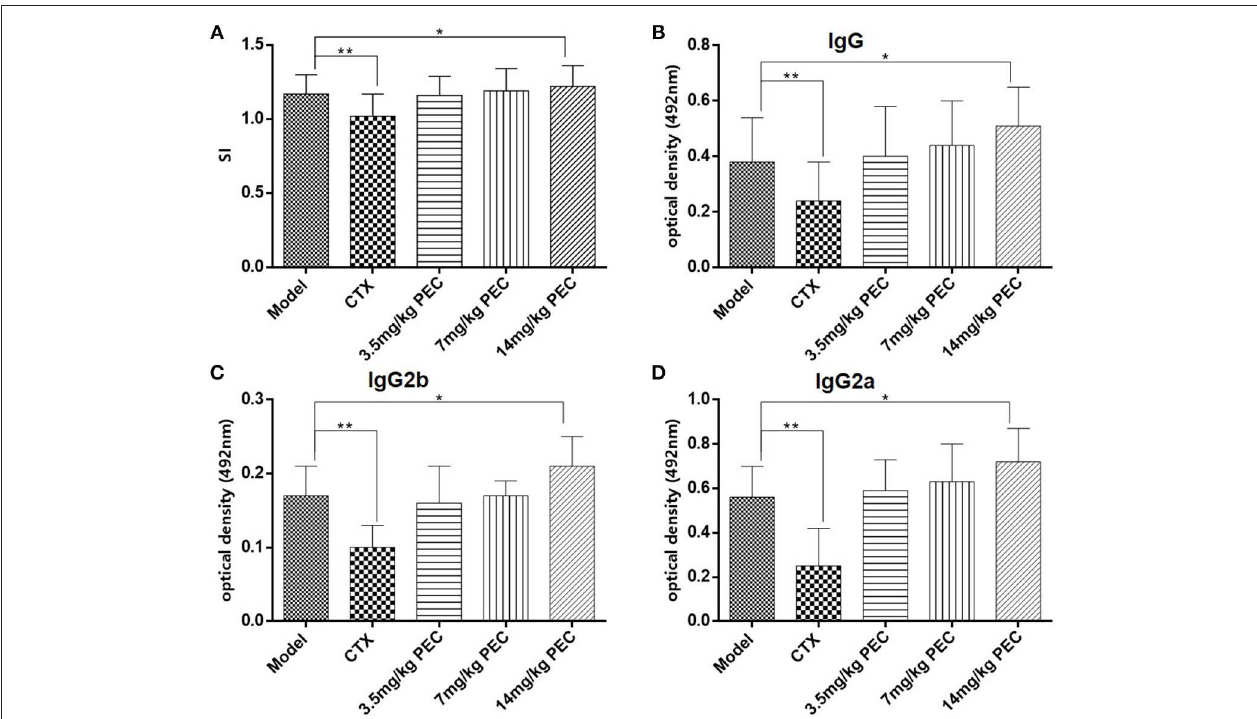
FIGURE 6 | (A) Effects of PEC on IL-2 production by splenic lymphocytes in S-180 tumor-bearing mice ( ¯ x ± s, n = 10). Effects of PEC on (B) IgG, (C) IgG2b, and (D) IgG2a in Serum of S-180 tumor-bearing mice ( ¯ x ± s, n = 10). Compared with model group: * P < 0.05, ** P <